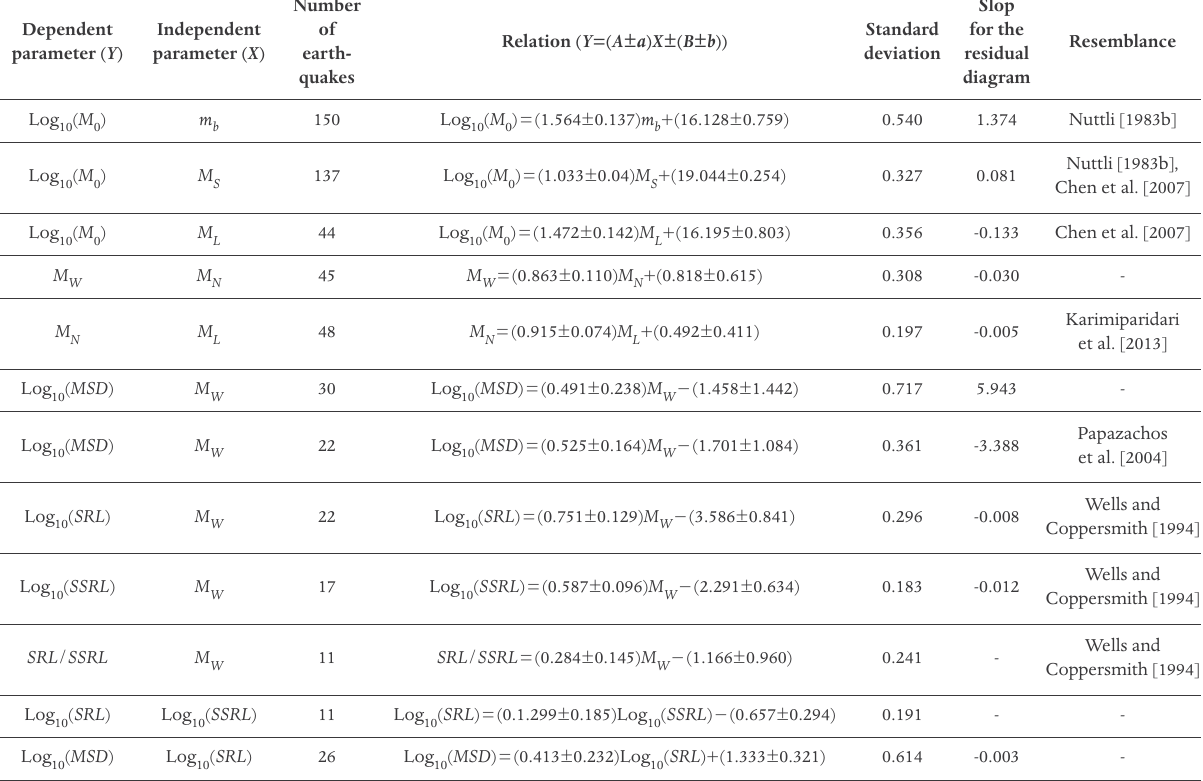
Table 1. Relationships and number of earthquakes used for each empirical